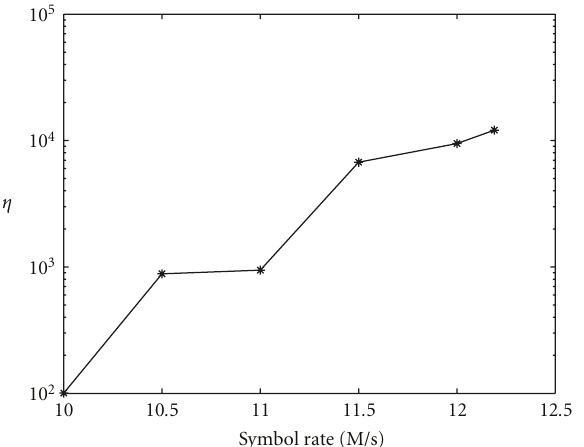
Figure 1: Comparison of η for di ff erent symbol rates.